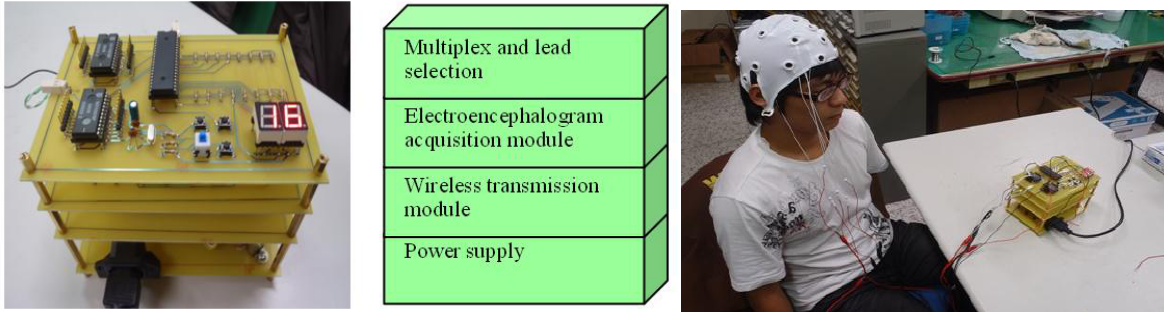
Figure 11. Photos for the presented EEG system and in a practical